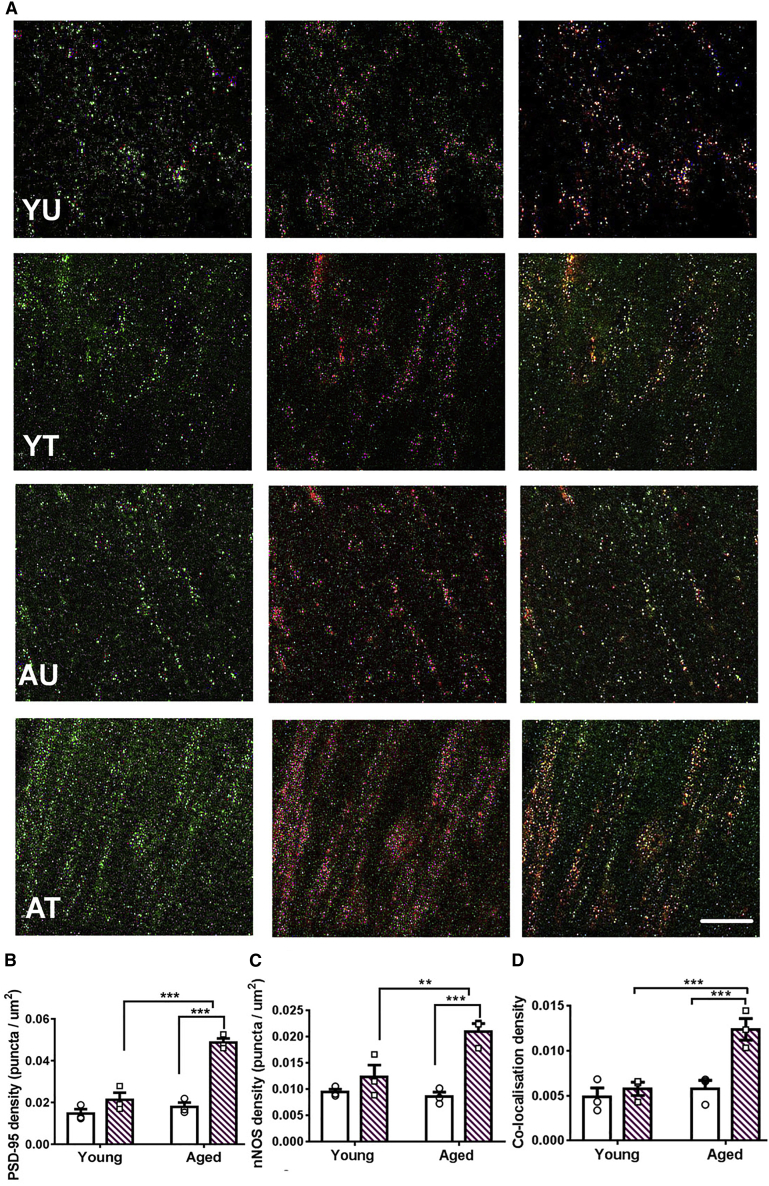
In Aged Mice, Contextual Fear Memory Formation Is Associated with Upregulation of PSD-95 and nNOS(A) PSD-95 upregulation is sufficient to induce MIS generation [37]. Representative images of separate co-immunolabeling experiments with PSD-95 (green) and neuronal nitric oxide synthase (nNOS; red) and merged images. The scale bar represents 20 μm.(B) Contextual fear memory formation in aged but not young mice was associated with PSD-95 upregulation (n = 3 each; effect of age, F(1,8) = 58.85, p < 0.0001; effect of CFC, F(1,8) = 39.41, p < 0.001; interaction CFC x age, F(1,8) = 24.42, p = 0.001; Tukey’s post hoc tests: AU versus AT, p < 0.0001; YT versus AT, p = 0.0002).(C) Contextual fear memory formation in aged but not young mice was associated with nNOS upregulation (n = 3 each; effect of age, F(1,8) = 8.16, p < 0.05; effect of CFC, F(1,8) = 24.2, p < 0.001; interaction CFC x age, F(1,8) = 7.22, p < 0.05; Tukey’s post hoc tests: YU versus YT, p = 0.15; AU versus AT, p < 0.001).(D) Contextual fear memory formation in aged but not young mice was associated with increased co-localization of PSD-95 and nNOS (n = 3 each; effect of age, F(1,8) = 24.1, p < 0.001; effect of CFC, F(1,8) = 32.0, p < 0.001; interaction CFC x age, F(1,8) = 14.9, p < 0.001; Tukey’s post hoc tests: YU versus YT, p = 0.21; AU versus AT, p < 0.001).Mean ± SEM, ∗∗∗p < 0.001, ∗∗p < 0.01, ∗p < 0.05. Individual data plots representing each animal within the group overlay the bar graphs. See also Figure S7.